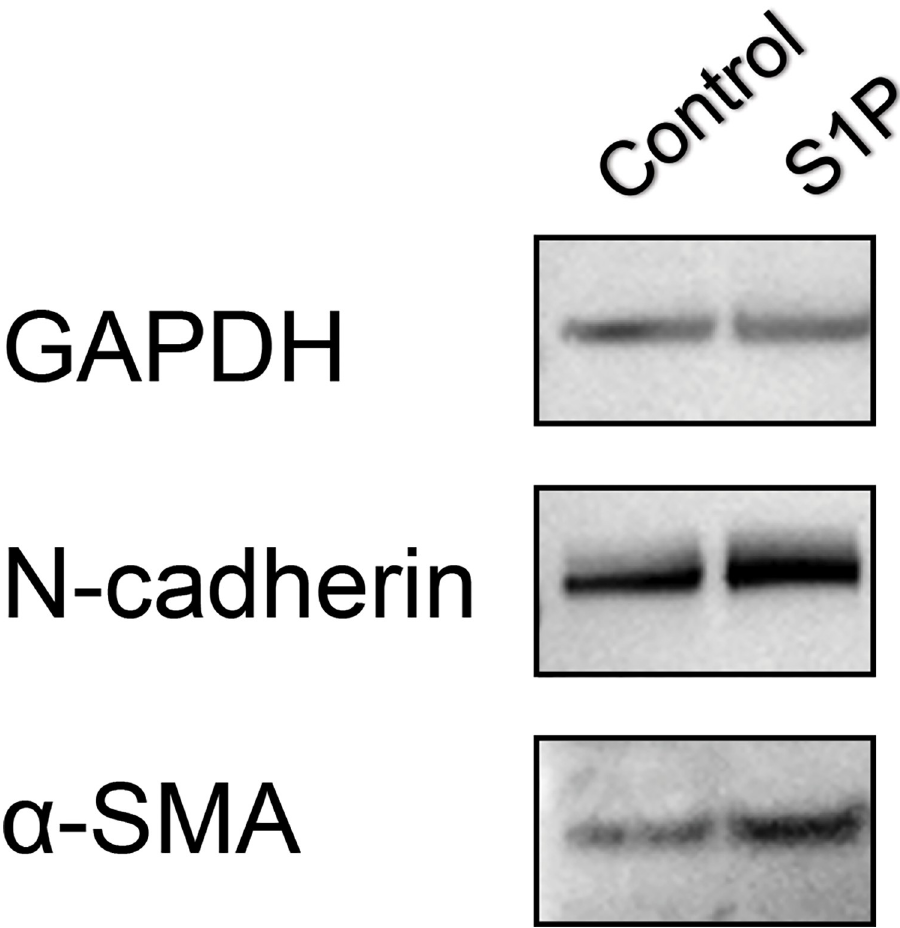
Fig 6. Changes in protein expression using Western blot analysis according to 10 mM sphingosine-1-phosphate (S1P) treatment. The expression of N-cadherin, and α -SMA was upregulated by S1P treatment.